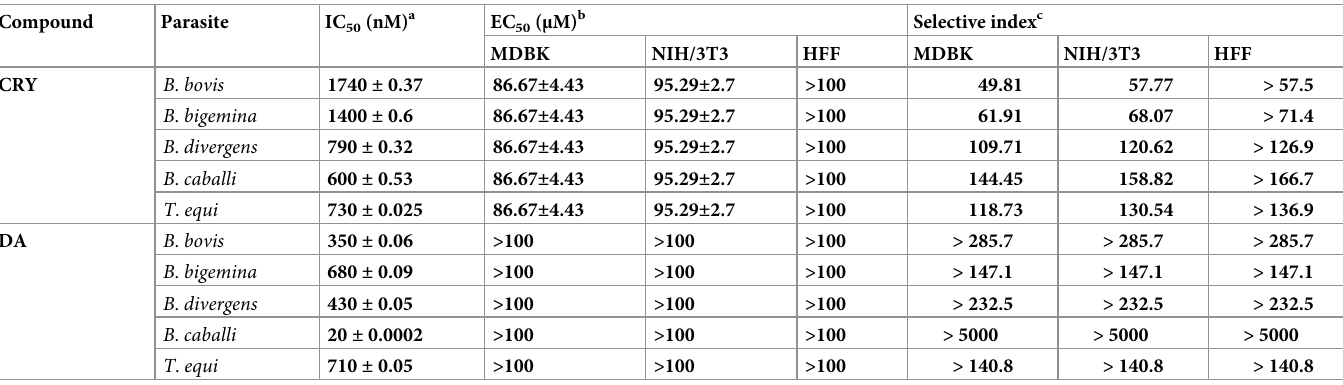
Table 1. The IC 50 and selectivity index of CRY and